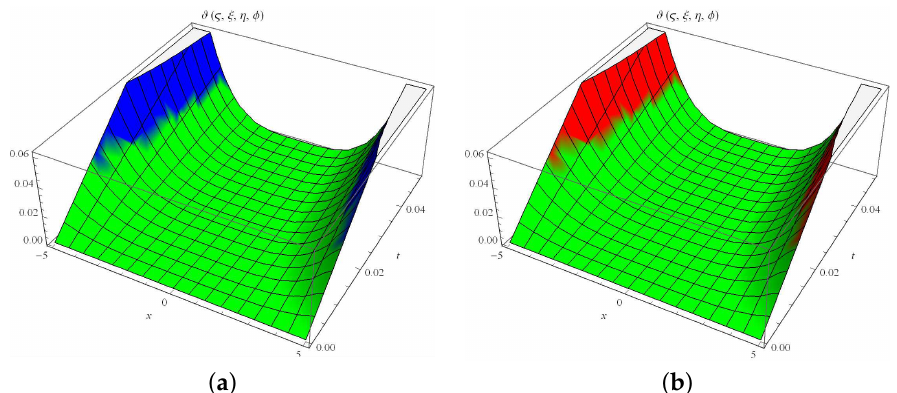
Figure 5. Surface solutions of 3D wave equation. ( a ) Surface plot for approximate results. ( b ) Surface plot for precise results.